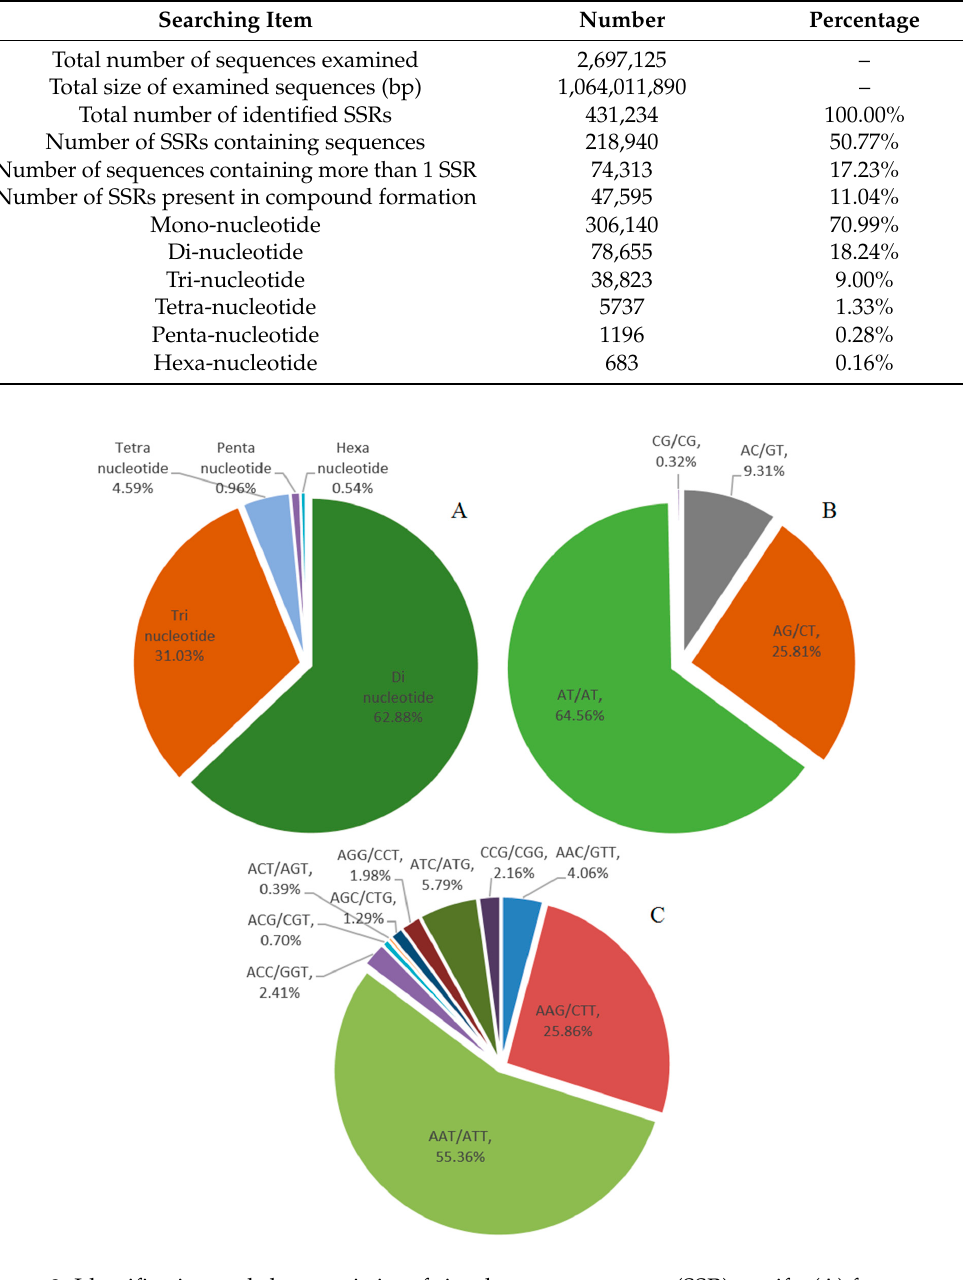
Figure 3. Identification and characteristics of simple repeat sequence (SSR) motifs: ( A ) frequency of different SSR motif repeat types; ( B ) frequency of different di-nucleotide SSR motifs; and ( C ) frequency of different tri-nucleotide SSR motifs.